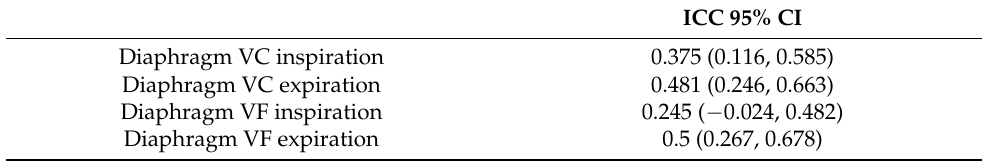
Table 4. ICC results for interobserver